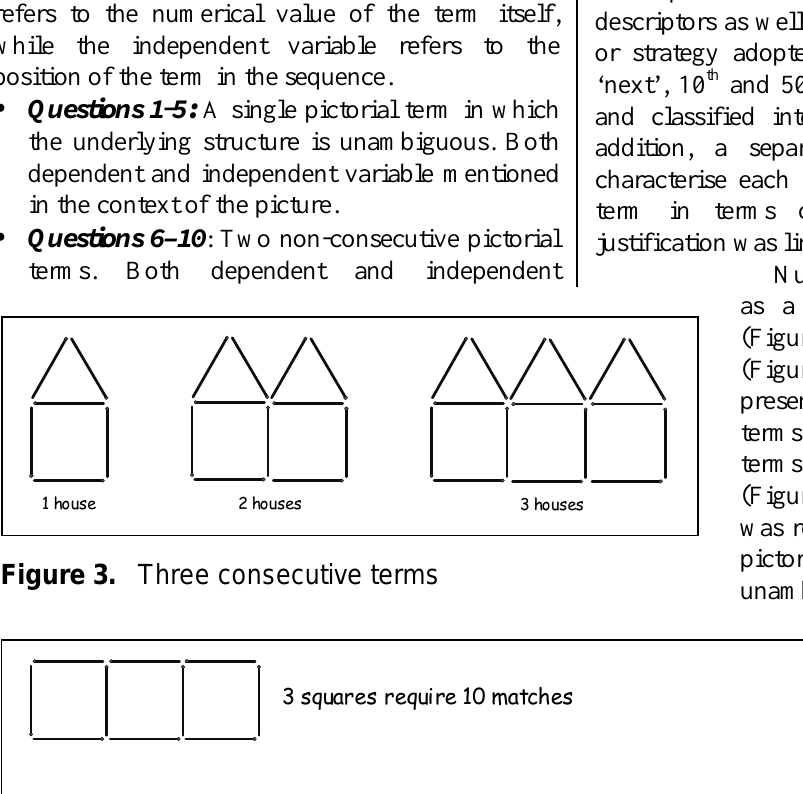
7 squares require 22